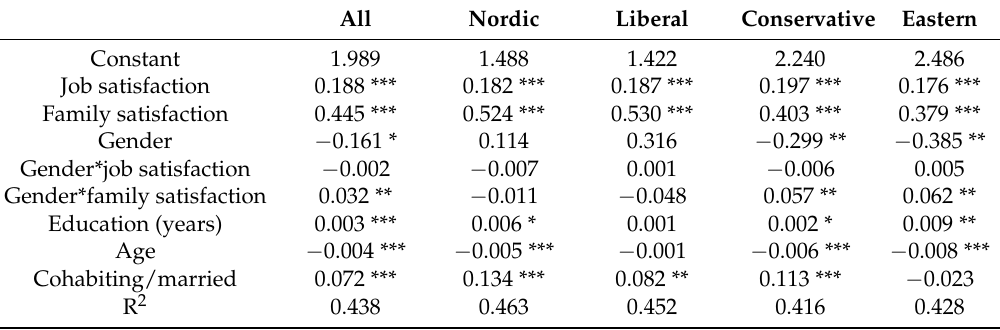
Table 4. OLS-regression. Job satisfaction, satisfaction with family life and gender by happiness in different gender regimes